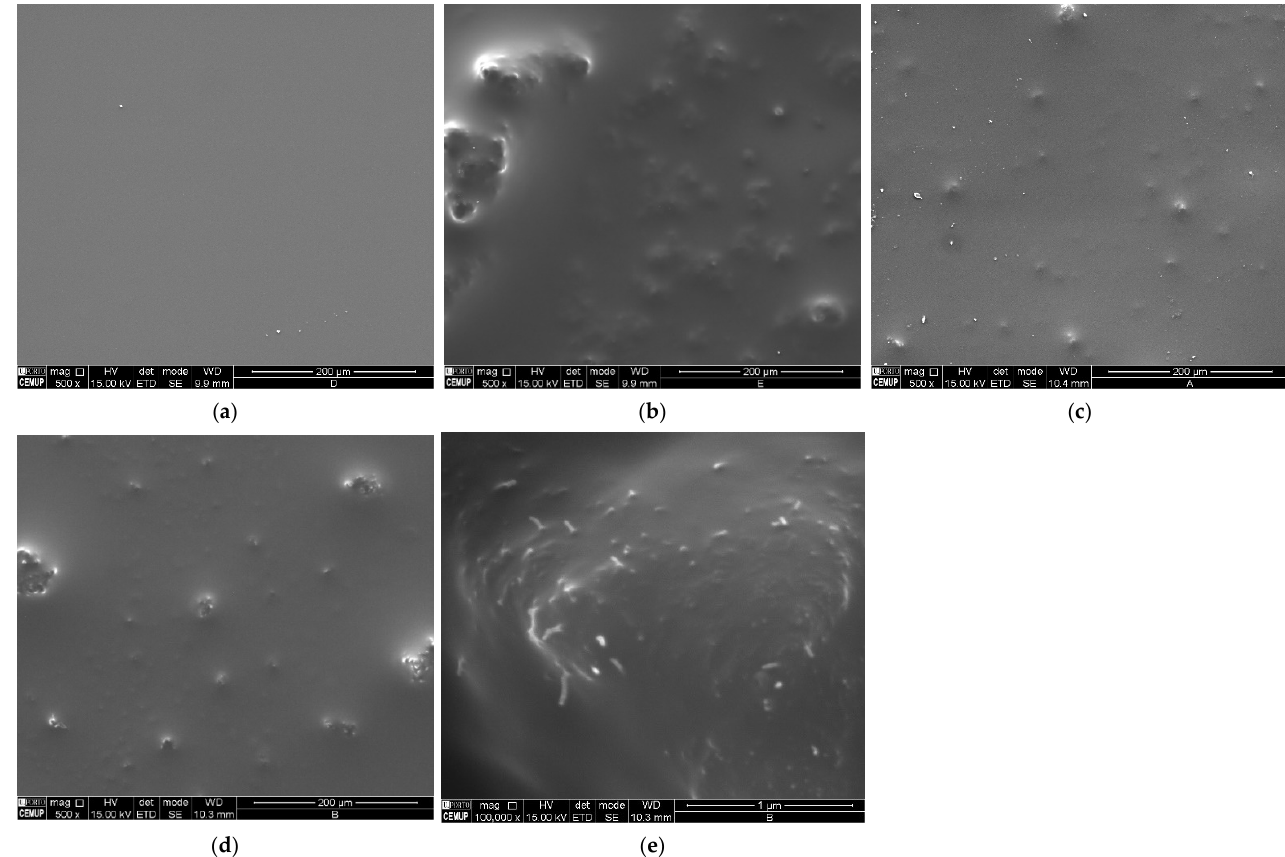
) between E. coli CECT 434 GFP and the different surfaces iwl